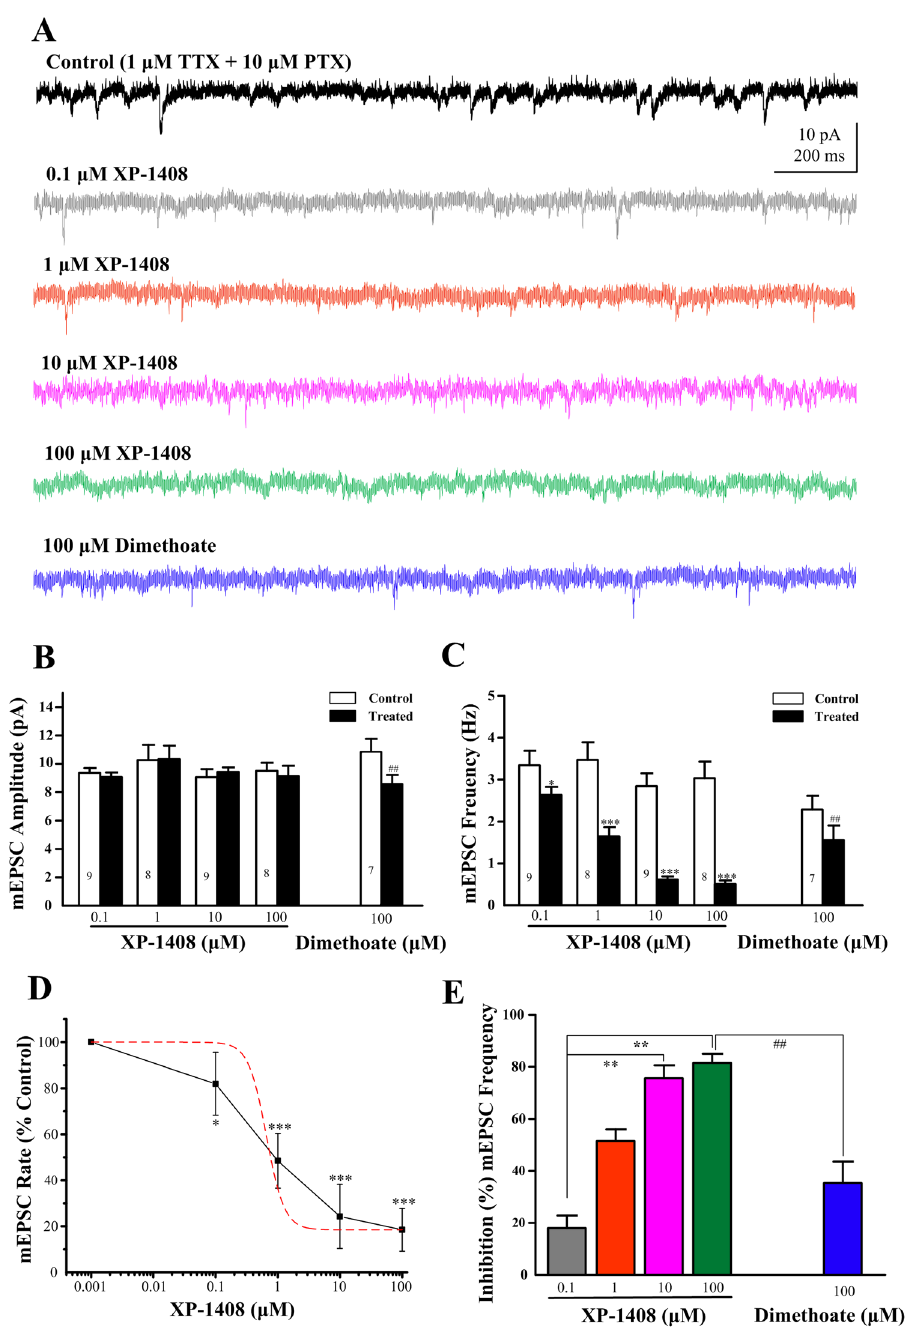
Figure 5. Effects of XP-1408 on cholinergic excitatory synaptic input to PNs. ( A ) Representative recordings show the effects of XP-1408 (0.1–100 μ M) and 100 μ M dimethoate on mEPSCs of PNs. ( B ) The mean mEPSCs amplitude in different concentrations of XP-1408 has no obvious change, but significantly decreased in 100 μ M dimethoate. ( C ) The mean frequency of mEPSCs in control saline is significantly reduced by acute application of different concentrations of XP-1408 and 100 μ M of dimethoate ( * P < 0.05, ** P < 0.01, *** P < 0.001 compared to control). Each bar indicates the mean ± SEM from the indicated number of neurons (n). ( D ) Concentration- response curve for XP-1408 inhibition of average mEPSC rate. Each symbol represents the mean ± SEM (n = 8–9). The IC 50 value was 0.66 μ M, determined from a dose-response logistic model (dashed line). ( E ) Plots of the percentage inhibition of mEPSC frequency 10 min after XP-1408 (0.1–100 μ M) and dimethoate (100 μ M) application, normalized to control values (100%). XP-1408 (0.1 μ M) vs. XP-1408(10 μ M), ** P < 0.01;